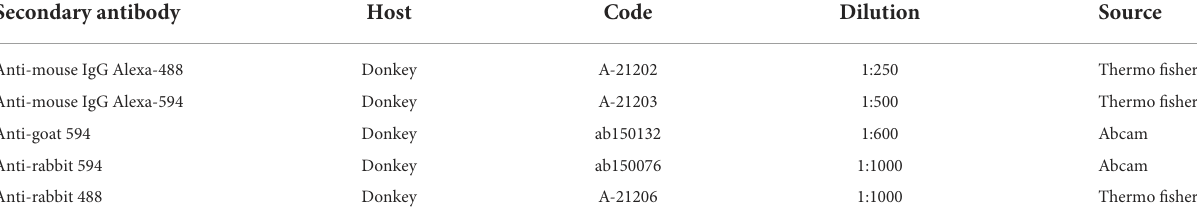
TABLE 3 Secondary antibodies used in the